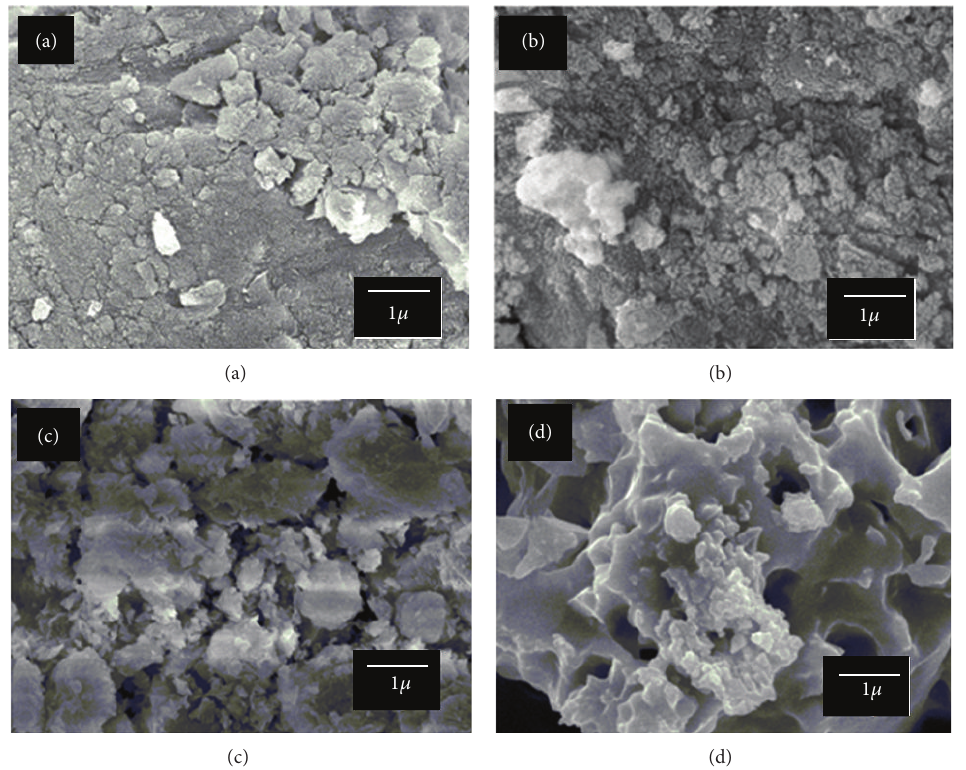
Figure 3: SEM profile of (a) Zr/MMT-5, (b) Zr/MMT-10, (c) S-Zr/MMT-5, and (d) S-Zr/MMT-10.